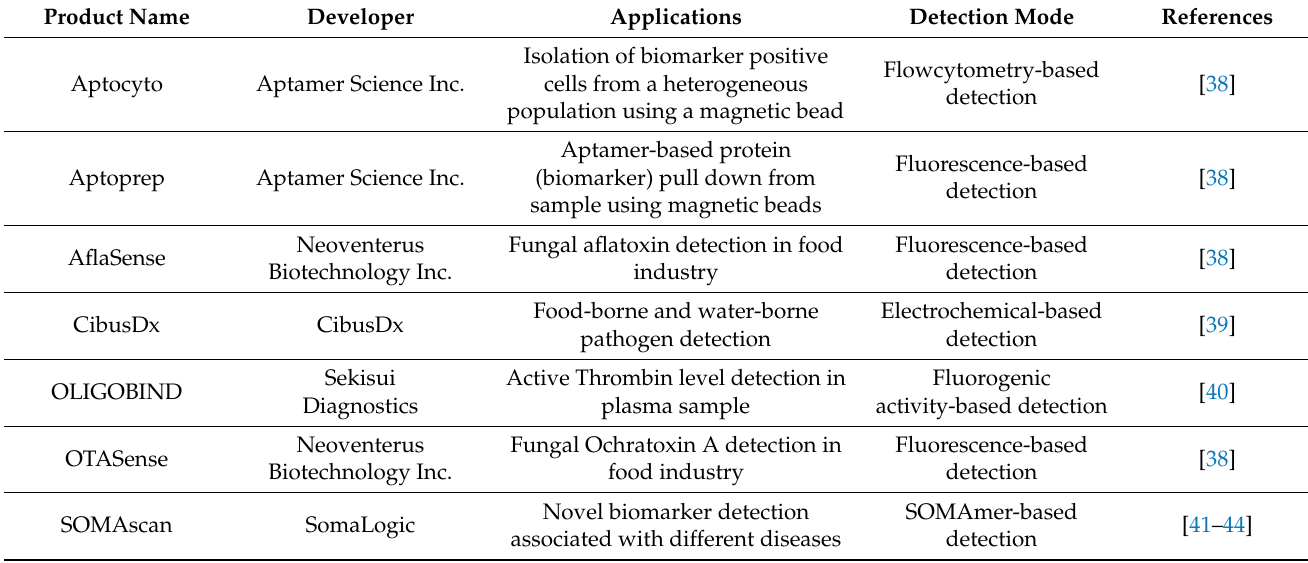
Table 1. Aptamer-based products in the diagnostic